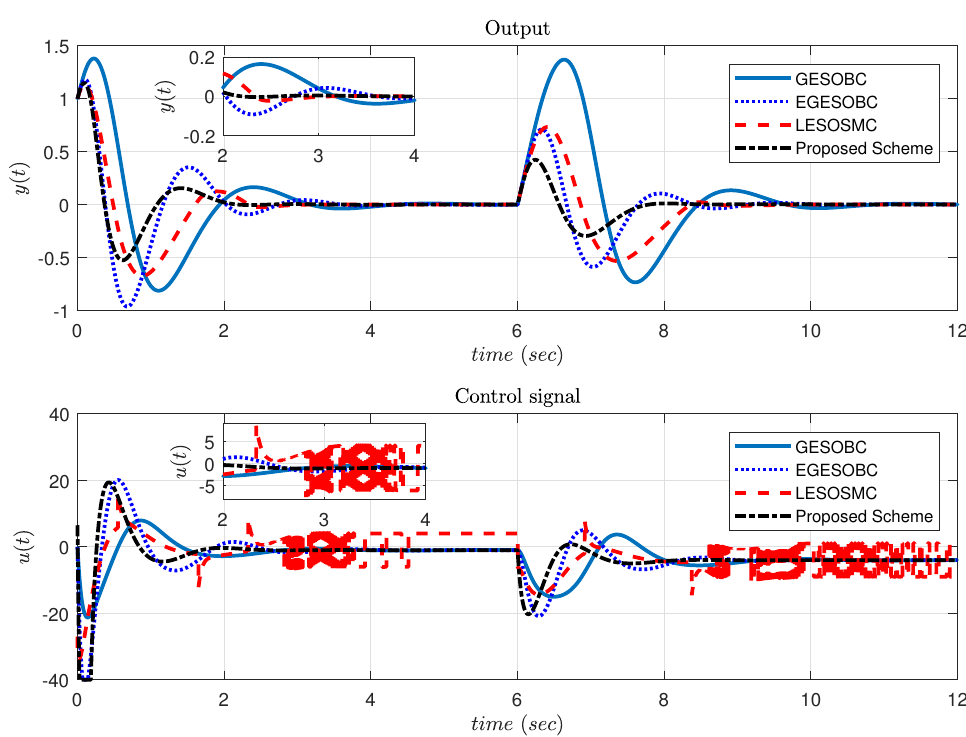
Figure 2. Response of output and control signal for Example 1.